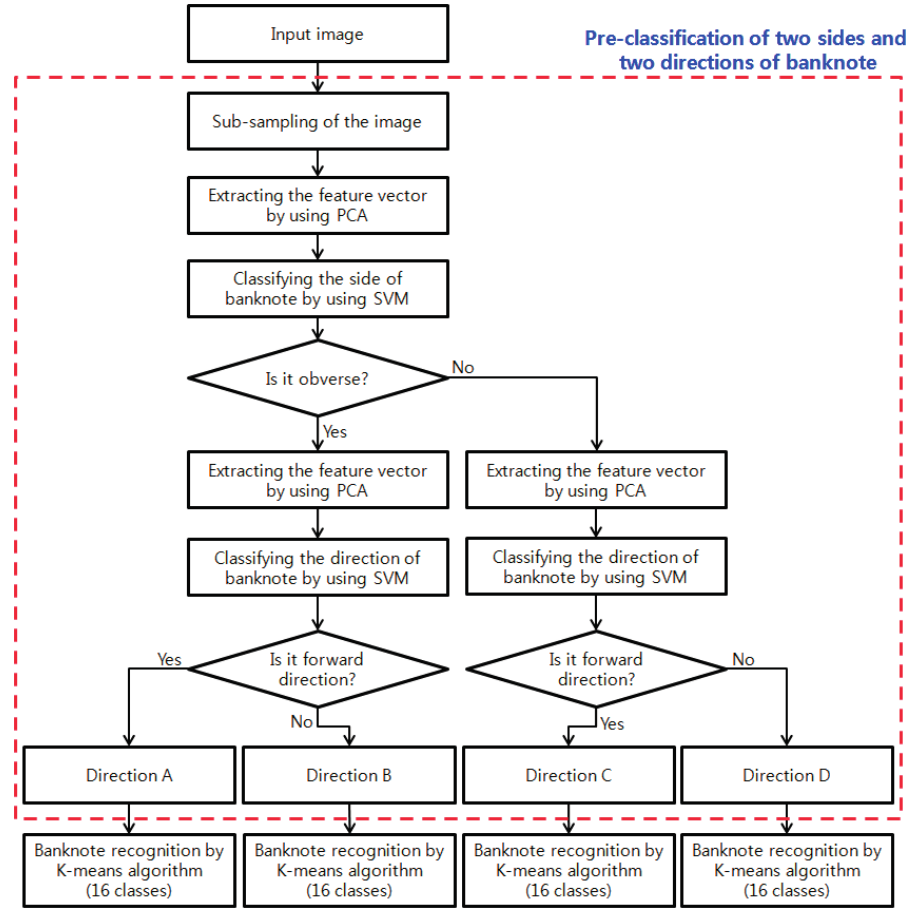
Figure 1. Overview of the proposed method.